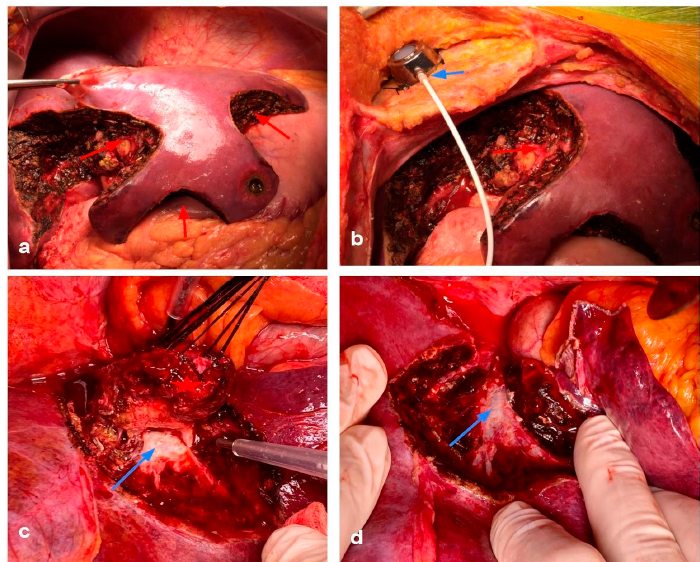
Figure 5. Parenchyma sparing surgery on a patient with multiple tumors. ( a , b ) The multiple bilobar resections with red arrows are shown. An intra arterial catheter for local chemotherapy was placed as well (blue arrow). ( c ) A tumor (red star) was in close proximity to the right hepatic vein (blue arrow). ( d ) It was removed with an R1 vasc approach, with preservation of the middle hepatic vein (blue arrow).